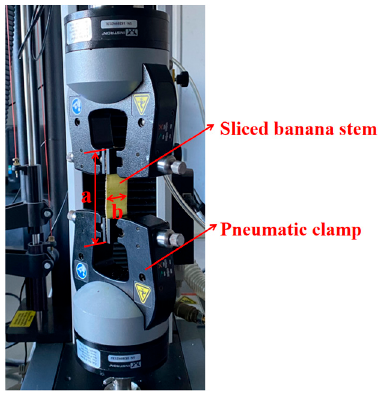
Figure 2. Straw tensile